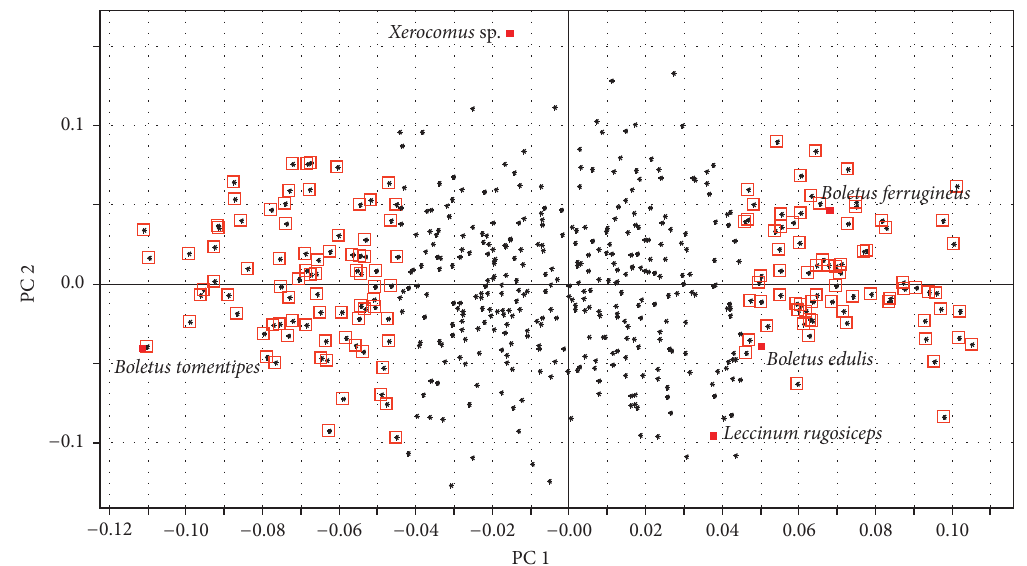
Figure 5: Loading plot generated from the PLS-DA model of the mushroom samples.